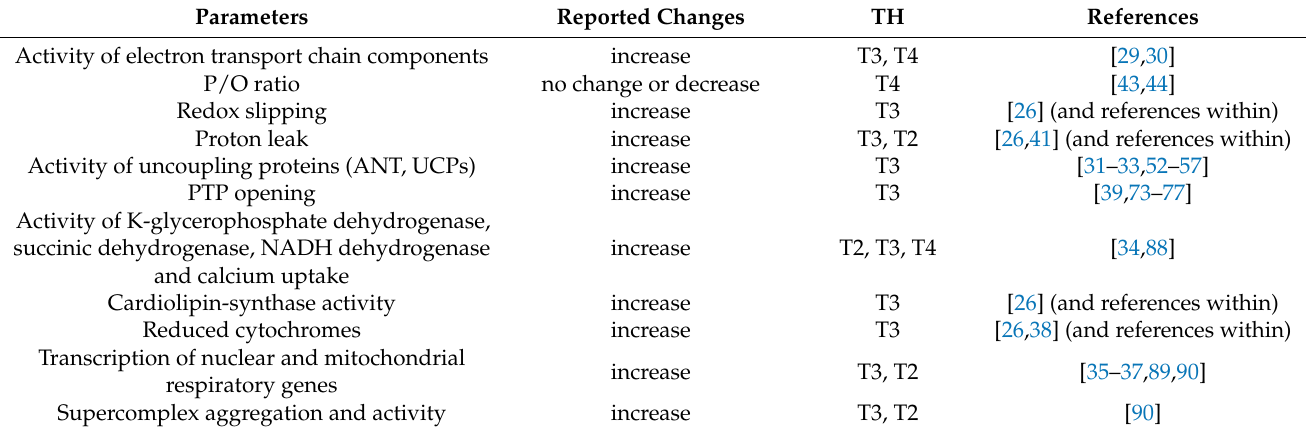
Table 1. Main general quali-quantitative effects of TH on the mitochondrial respiratory